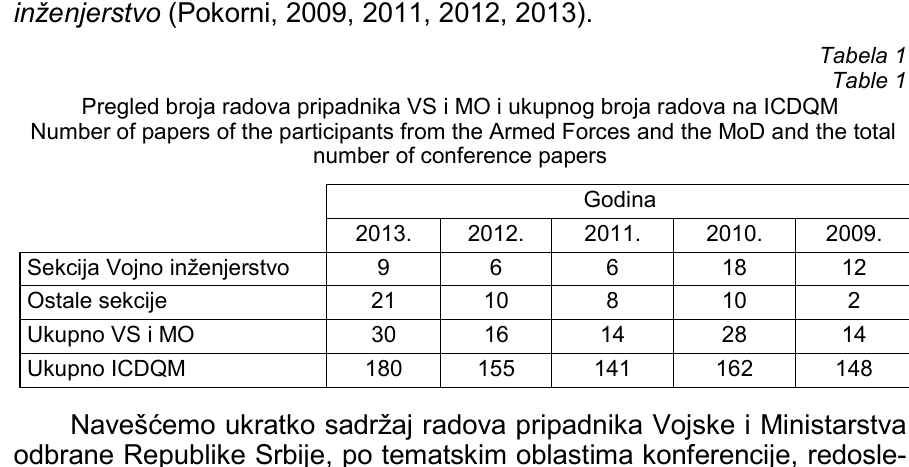
Naveš ć emo ukratko sadržaj radova pripadnika Vojske i Ministarstva odbrane Republike Srbije, po tematskim oblastima konferencije,